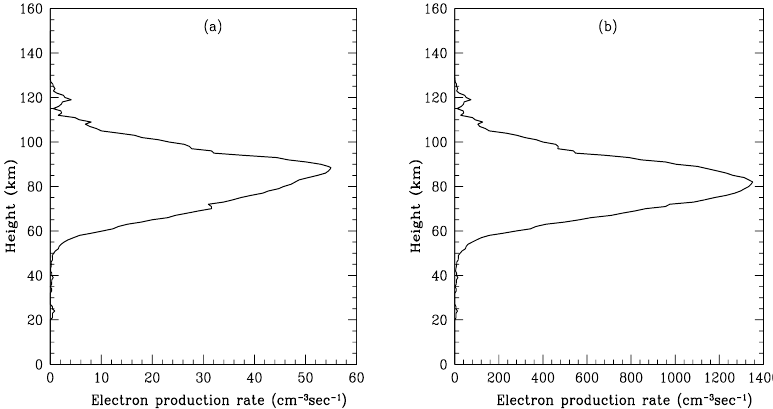
Fig. 3. Electron production rates per unit volume at peak times for the (a) M-class flare and the (b) X-class flare assuming the Sun to be at zenith.